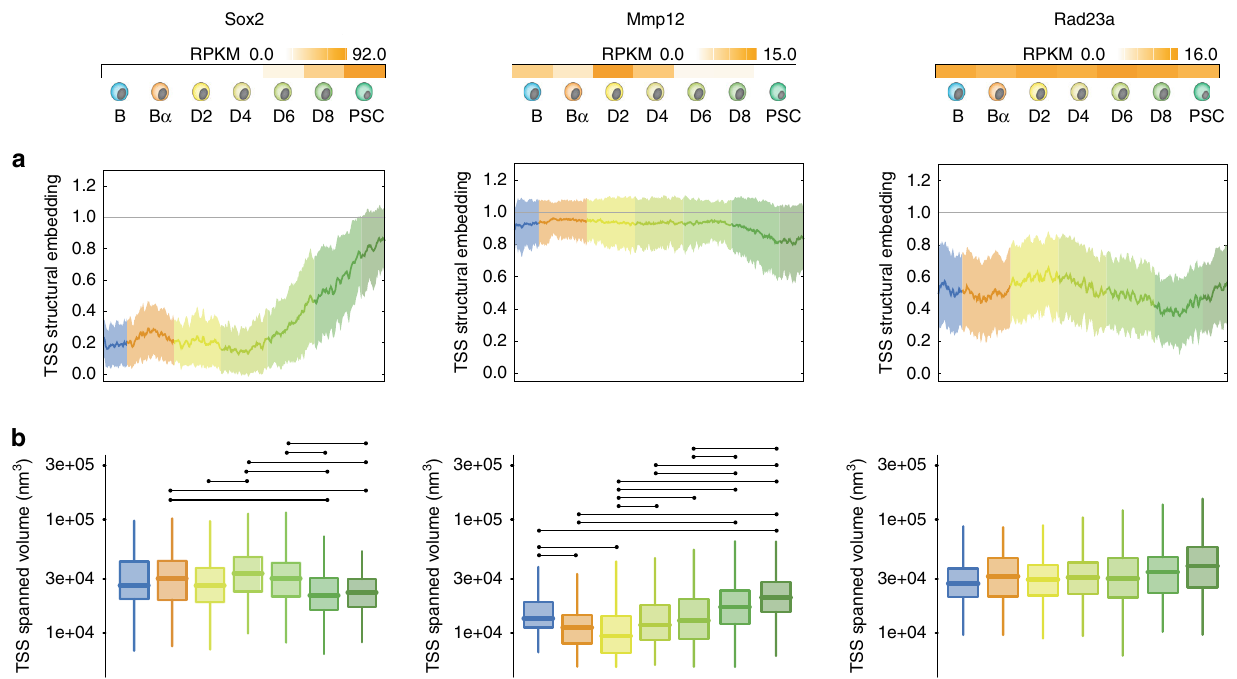
Fig. 3 Gene activity correlates with TSS structural embedding and spanned volume. Top of the fi gure indicates expression level (RPKM) for each of the selected loci at each reprogramming stage 35 . a Dynamic structural embedding of the TSS particle. Each central line and the surrounding shadowed area represent respectively the average and the standard deviation interval of the pro fi le over the 100 TADdyn replicates. b Volume explored by the TSS particle during the various stages of the reprogramming dynamics. The convex-hull values are represented as boxplots ( n = 100 values for B and PSC and n = 200 values for the other cell stages) showing: central line, median; box limits, 75th and 25th percentiles; whiskers, 1.5× interquartile range. Outliers are not shown. Connecting lines between distributions indicate they are statistically different ( p < 0.0001, two-sided Wilcoxon rank sum test). Exact signi fi cant p- values are: Sox2 ( p B α -D8 = 3.7e-08 , p B α -PSC = 8.1e - 06, p D2-D4 = 2.0e-06, p D4-D8 = 5.0e-14, p D4-PSC = 7.8e-10, p D6-D8 = 6.9e-09, p D6-PSC = 3.6e-06); Mmp12 ( p B-B α = 7.4e-08, p B-D2 = 4.0e-15, p B-PSC = 2.6e-07, p B α -D8 = 3.8e-17 , p B α -PSC = 7.5e - 20, p D2-D4 = 3.3e-08, p D2-D6 = 3.5e-10, p D2-D8 = 5.4e-27, p D2-PSC = 7.4e-26, p D4-D8 = 5.4e-11, p D4-PSC = 4.7e-15, p D6-D8 = 1.8e-07, p D6-PSC =